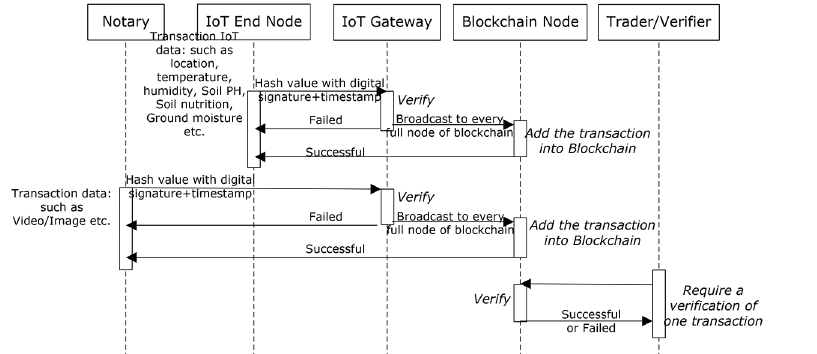
Figure 3. Transaction data process fl